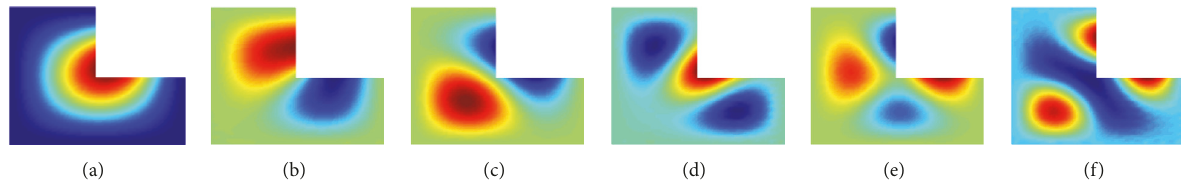
Figure 6: The first six mode shapes of the square plate with an edge cutout. (a) The first mode; (b) the second mode; (c) the third mode; (d) the fourth mode; (e) the fifth mode; (f) the sixth mode.